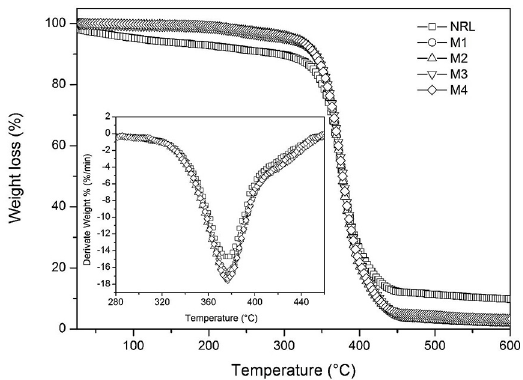
Figure 4. DSC curves for natural rubber latex (NRL) and membranes M1, M2, M3 and